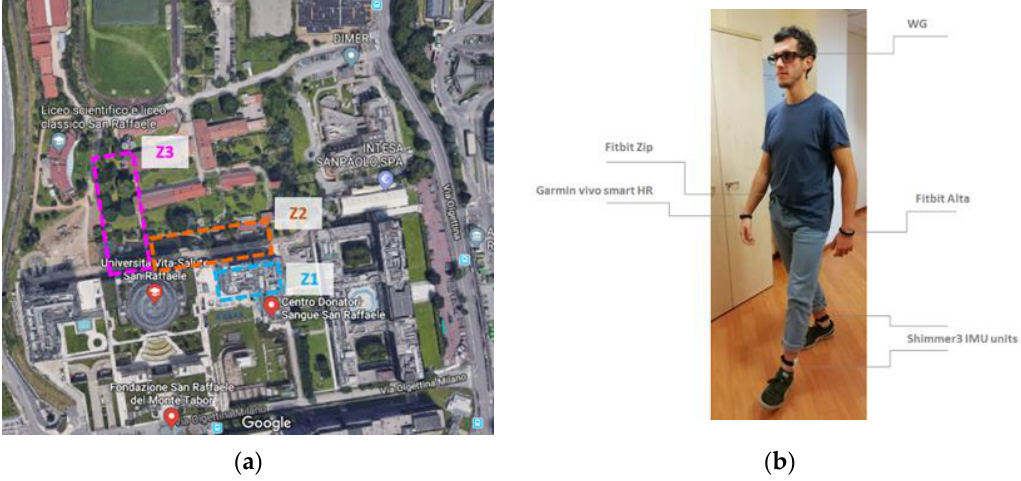
Figure 3. ( a ) Predefined path at San Raffaele Hospital and ( b ) the experimental setup.